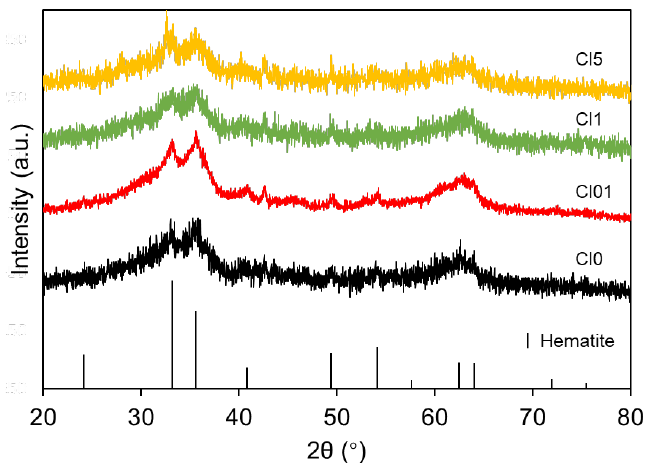
Figure 2. XRD patterns of freshly prepared precipitated iron catalysts with chlorine.